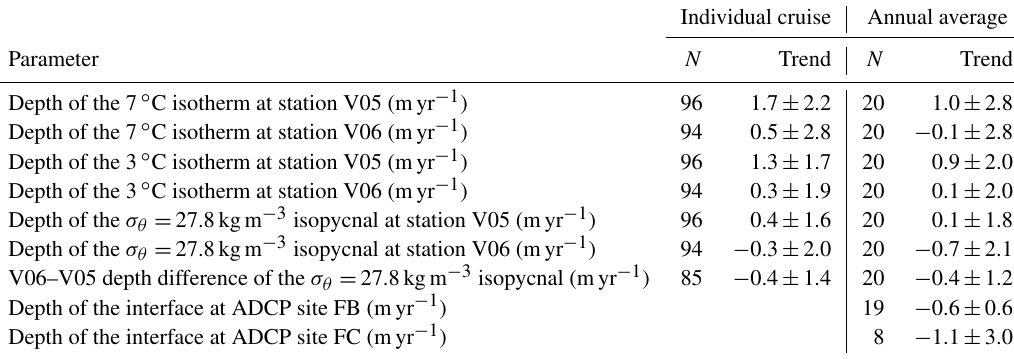
Table 3. Linear trends of various parameters through the observational period. For the hydrographic parameters, the table shows both the trend calculated from individual cruises and the trend calculated from annual averages (excluding the annual servicing period from day 136 to day 195 for the ADCP data). N is the number of values in each